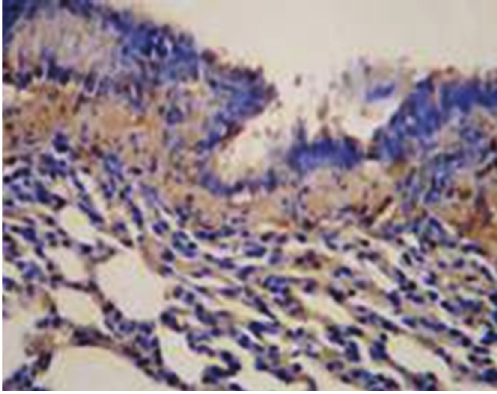
Figure 8: Model control group-21d mucous membrane of small intestine (+++) Bax × 200.